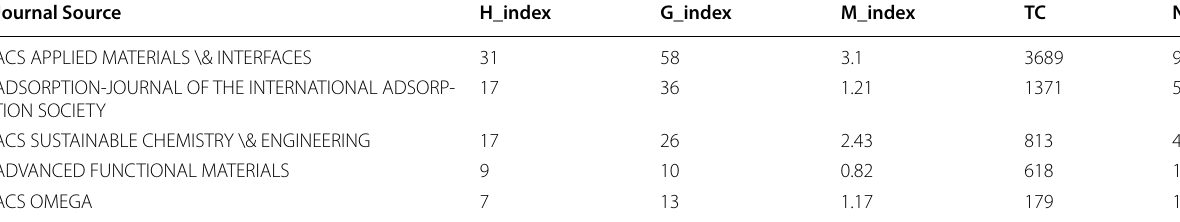
Table 5 Combined, journal source